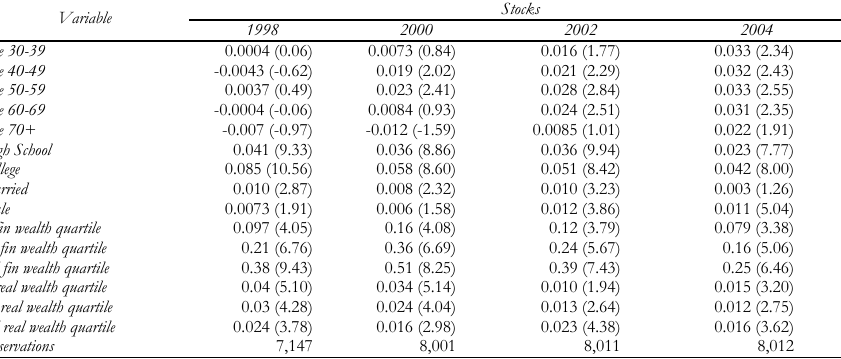
Cross-sectional Probit Regressions for Direct Stockholding The coefficients in the table indicate the marginal effect of the regressor on the probability of stockownership. Each of the regressors is a dummy variable. z-statistics are reported in parenthesis